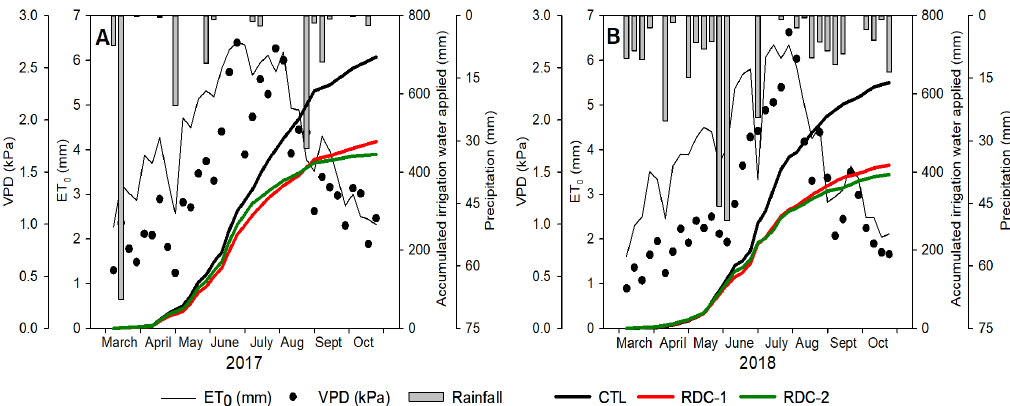
Figure 1. Seasonal evolution of weekly mean air vapor pressure deficit (VPD) and reference evapotranspiration (ET 0 ) and accumulated weekly precipitation and accumulated irrigation water applied to each treatment during the season 2017 (A) and 2018 (B) in the ‘Prime Giant’/SL64 sweet cherry orchard in Jumilla (Spain).